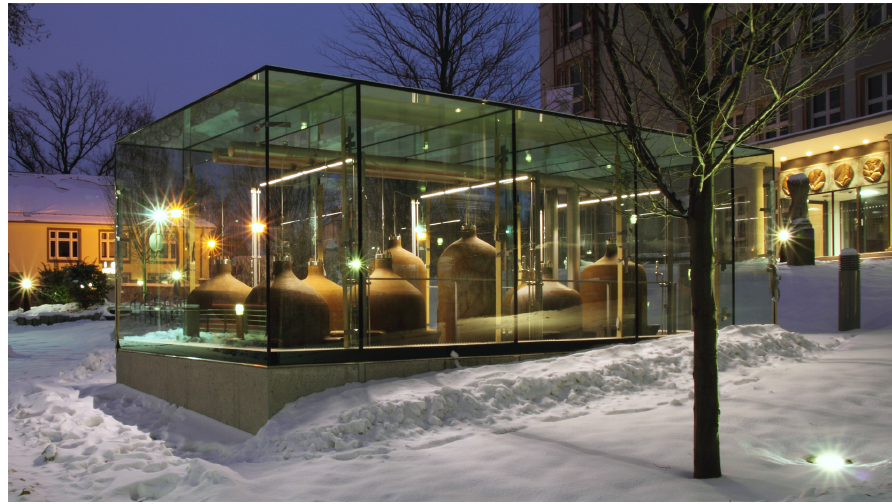
Figure 10: Glass construction after